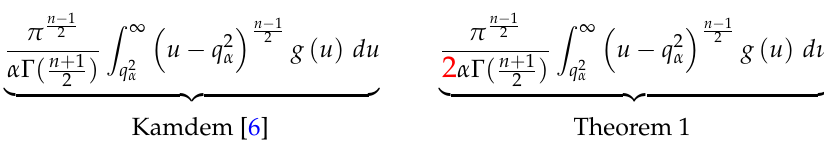
Figure 1. Comparison of the formula for expected shortfall for an elliptical distribution at quantile α